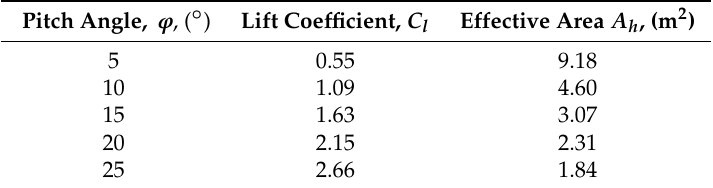
Table 3. Effective area required for a plate tail fin at different pitch angles, l = 50 m, s = 20